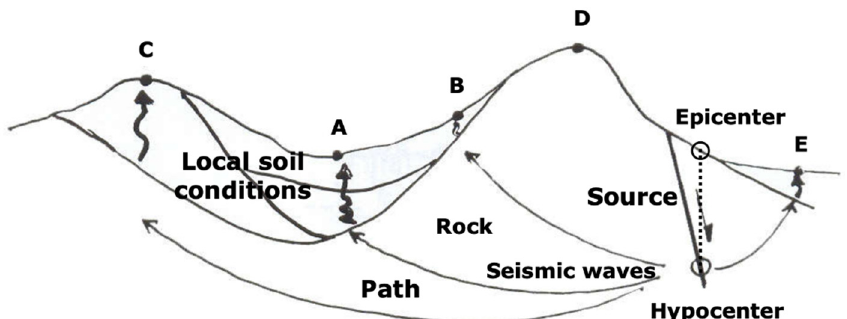
Figure 3. Example of factors that influence the intensity and extent of ground motion generated by an earthquake: (1) position of the hypocenter (or of the epicenter, i.e., hypocenter projection on the surface); (2) distance between earthquake source and site of interest (e.g., points A, B, C, D in the picture); (3) local site conditions (soil type profile and morphology).